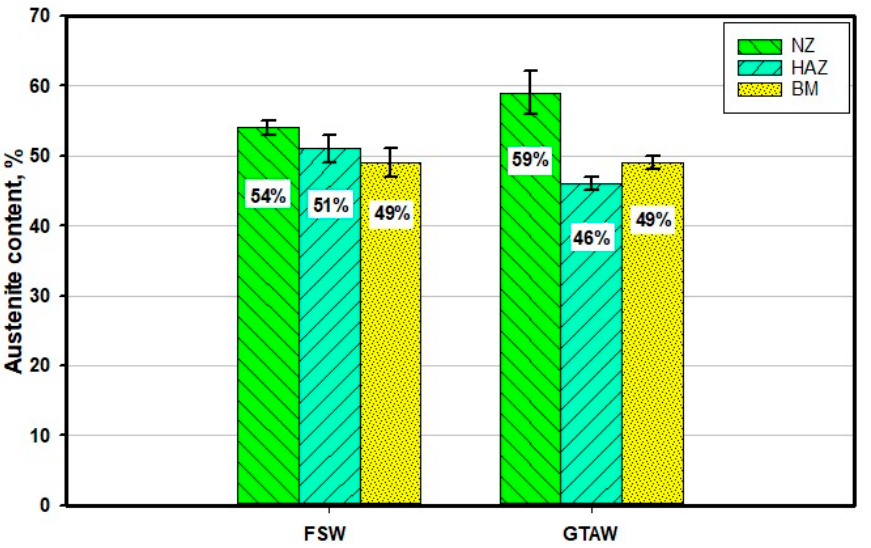
Figure 12. Austenite contents (%) in microstructural zones of the FSWed joint produced using a 60 o V groove with root face and GTAWed 2205 DSS obtained using a ferrite-scope type of FERITSCOPE MP30. Note: for the FSWed sample, WZ represents the SZ and HAZ represents both TMAZ/HAZ. MP30. Note: for the FSWed sample, WZ represents the SZ and HAZ represents both